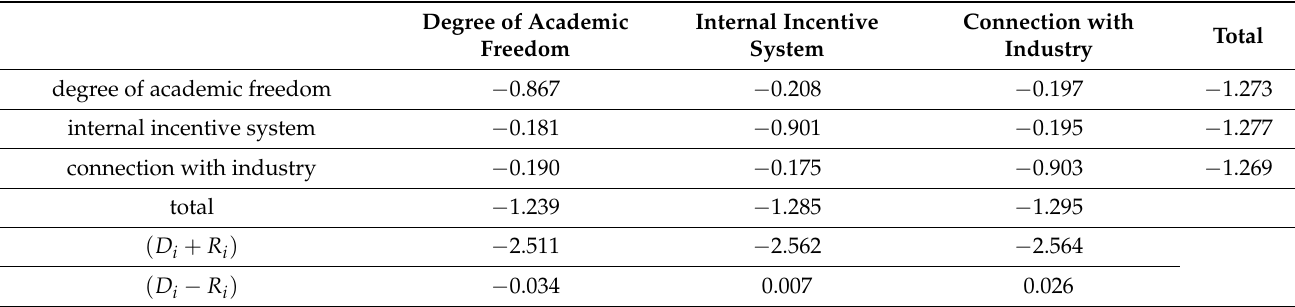
Table 4. The casual matrix of sub-aspects of organizational structure and system.